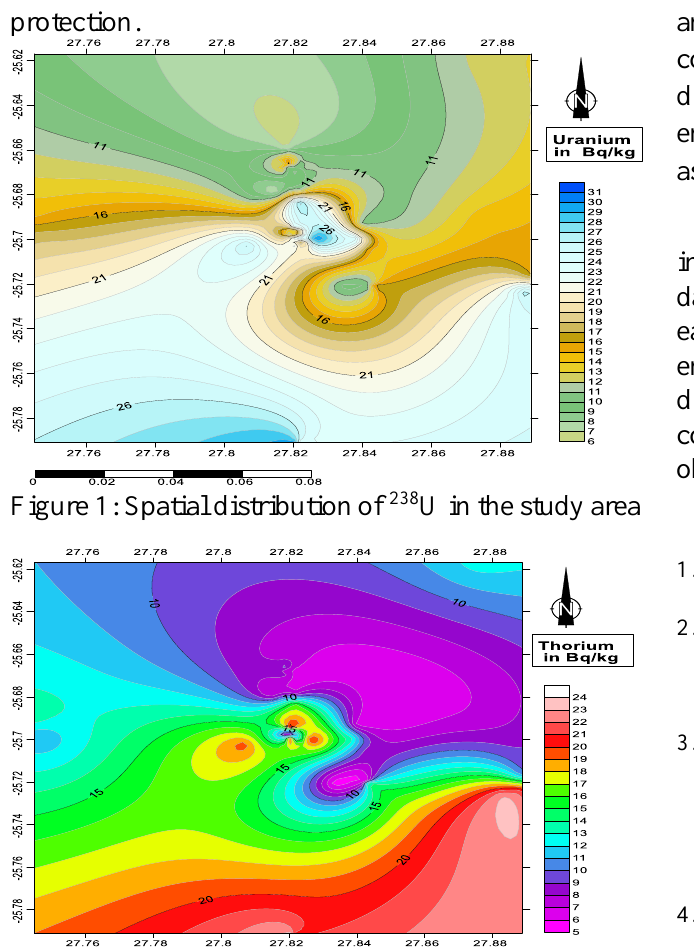
Figure 2: Spatial distribution of 232Th in the study area